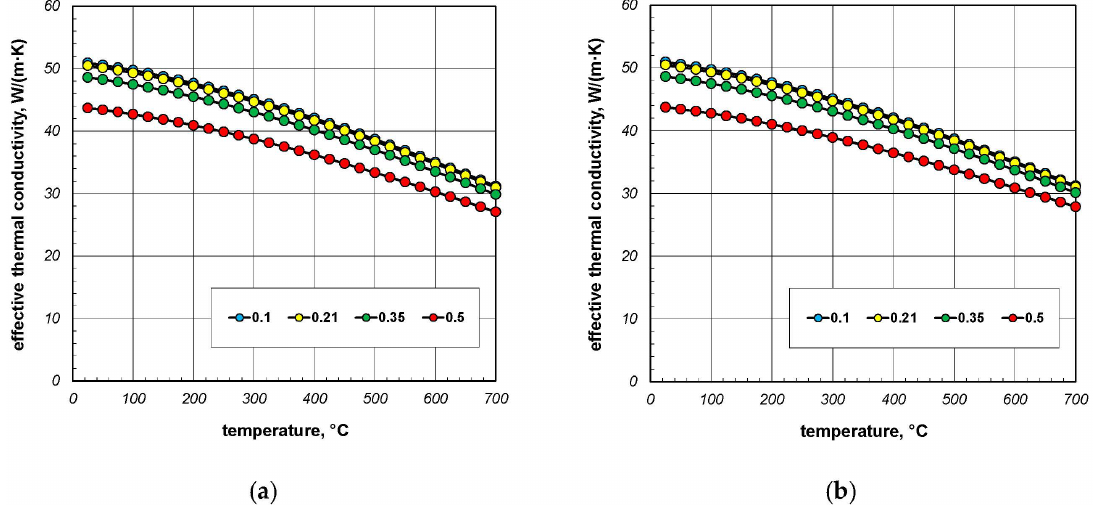
Figure 24. Calculated values of the effective thermal conductivity for a porous charge of a granular structure: ( a ) results for δ = 10 mm; ( b ) results for δ = 40 mm. The values visible in the key refer to the porosity of the